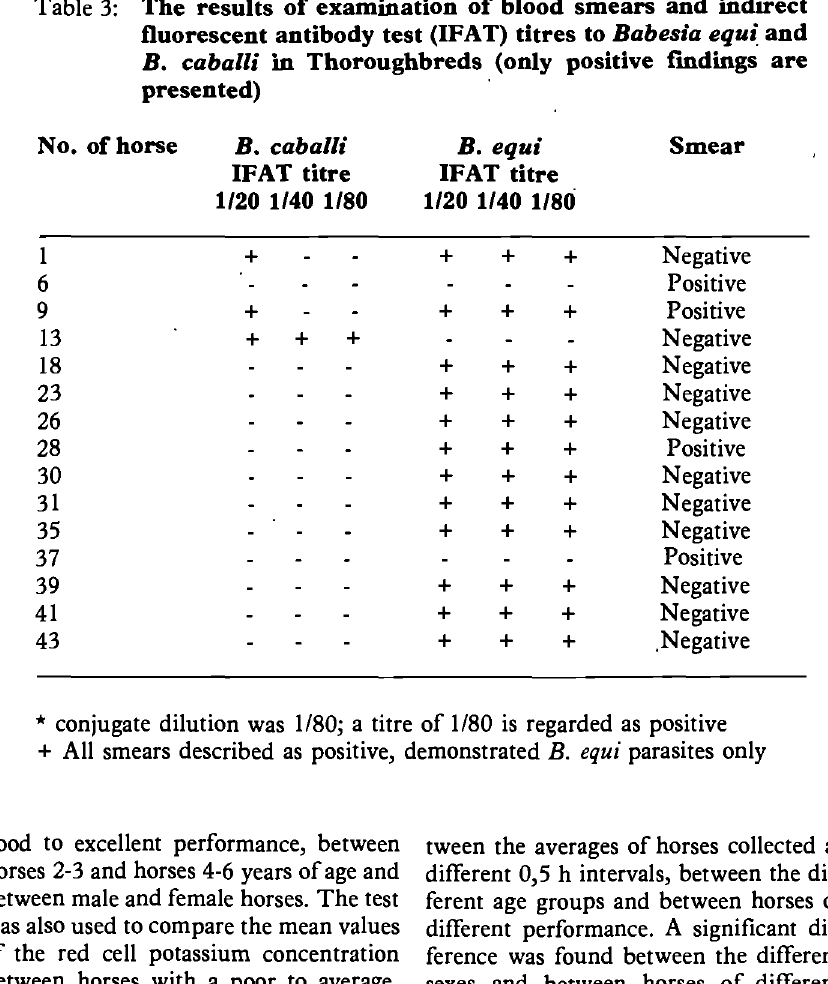
Table 3: The results of examination of blood smears and indirect fluorescent antibody test (IF A T) titres to Babesia equi and B. caballi in Thoroughbreds (only positive f'mdings are presented) , No. of